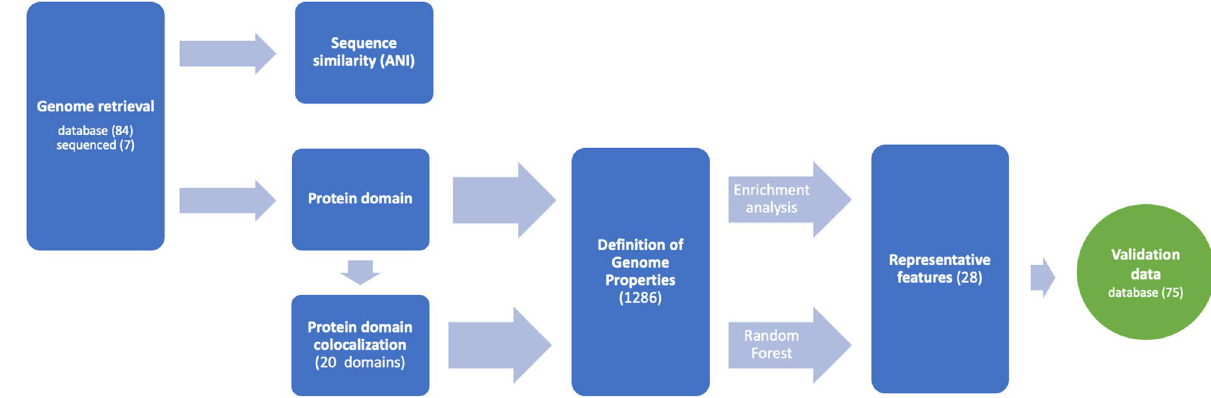
Figure 1. Workflow for GPs based functional genomics and classification. Genome sequences are analyzed using sequence similarity and protein domain content. (Colocalized) protein domain content is used to infer Genome Properties. Enrichment analysis and Random Forest feature selection was used obtain genomic features. Classification performance was evaluated using a test set of 75 newly available